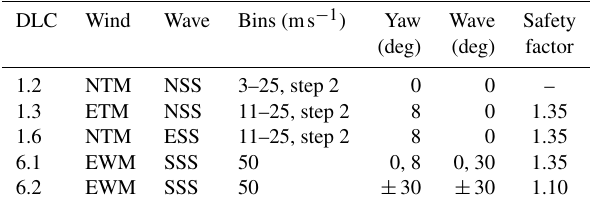
Table 3. Definition of DLCs for the time-domain hydro-aero-servo- elastic analysis. See the Appendix for definitions of the abbrevia-